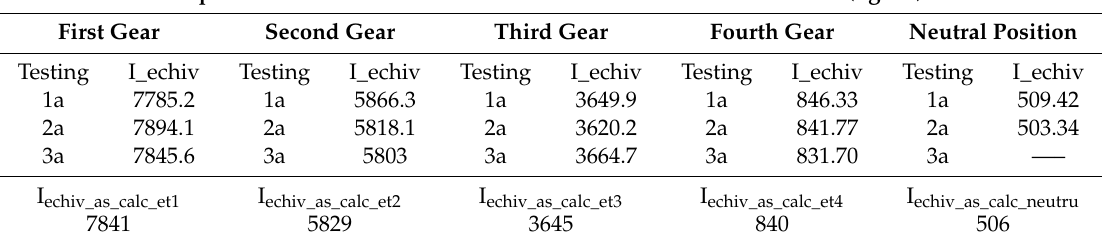
Table 5. Equivalent moment of inertia reduced at the drive wheel determined by the computer-assisted gravitational